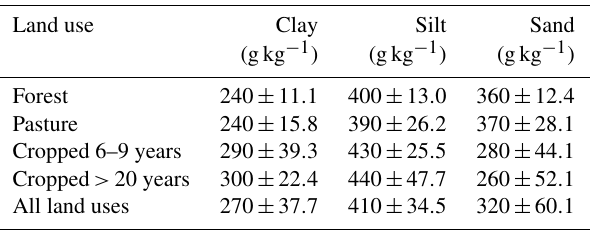
Table 2. Mean values and standard errors of soil particle size dis- tribution in the 0–20cm layer for different land